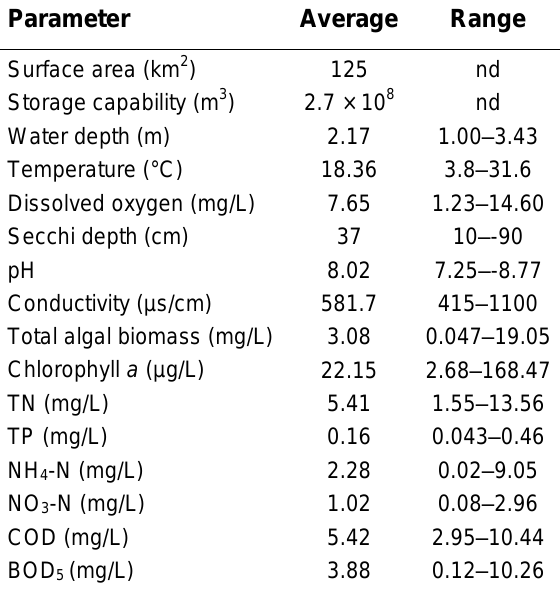
The Average Values and Ranges of Selected Morphometrical and Limnological